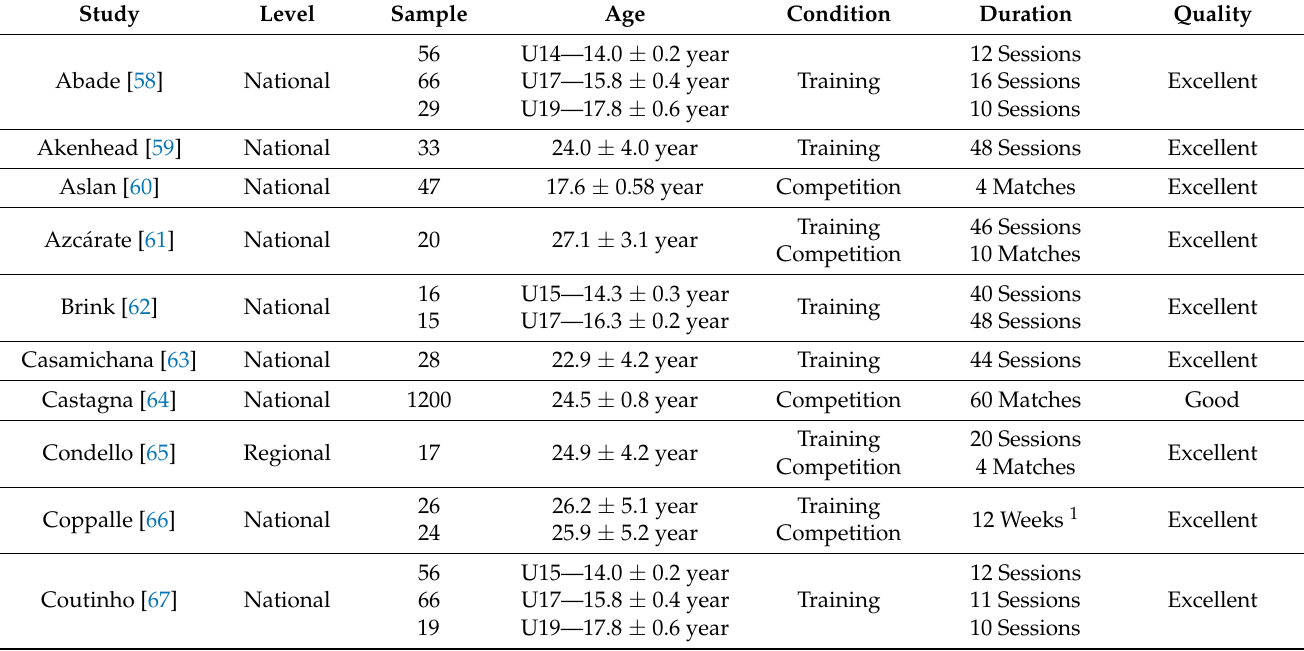
Table 3. Characteristics of studies that evaluated both internal and external load